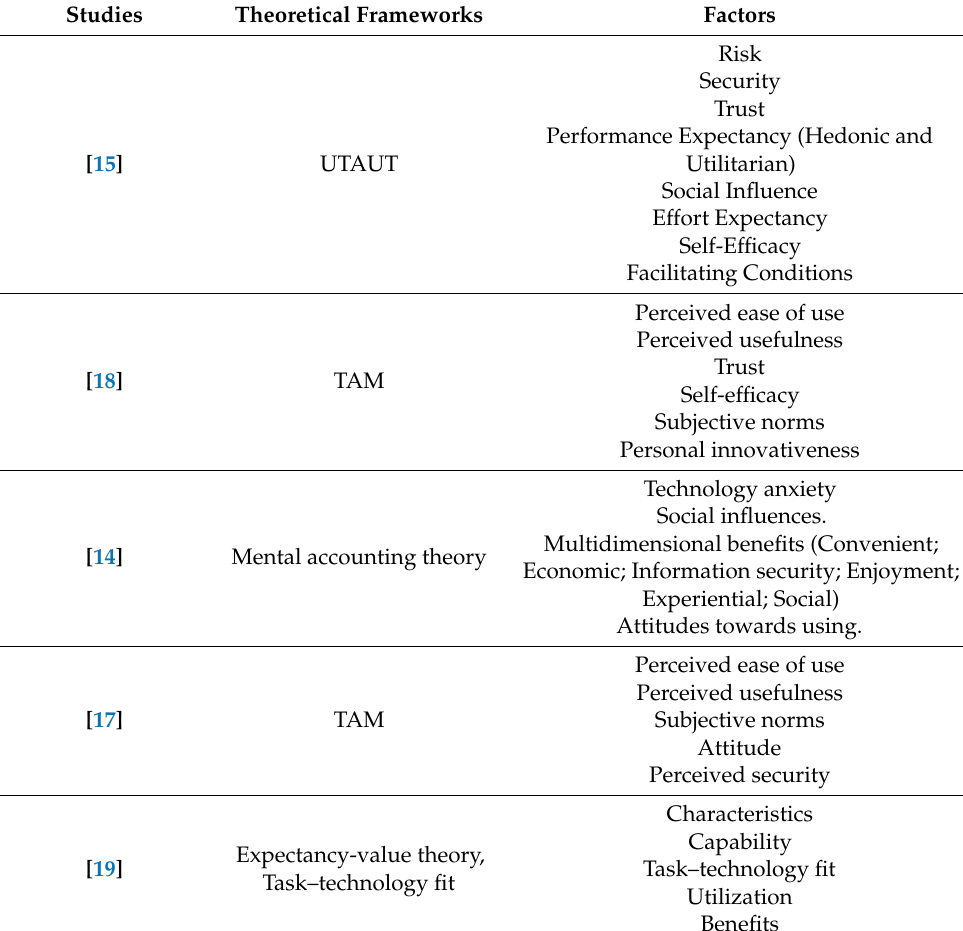
Table 1. Literature reviews related to Mobile payment